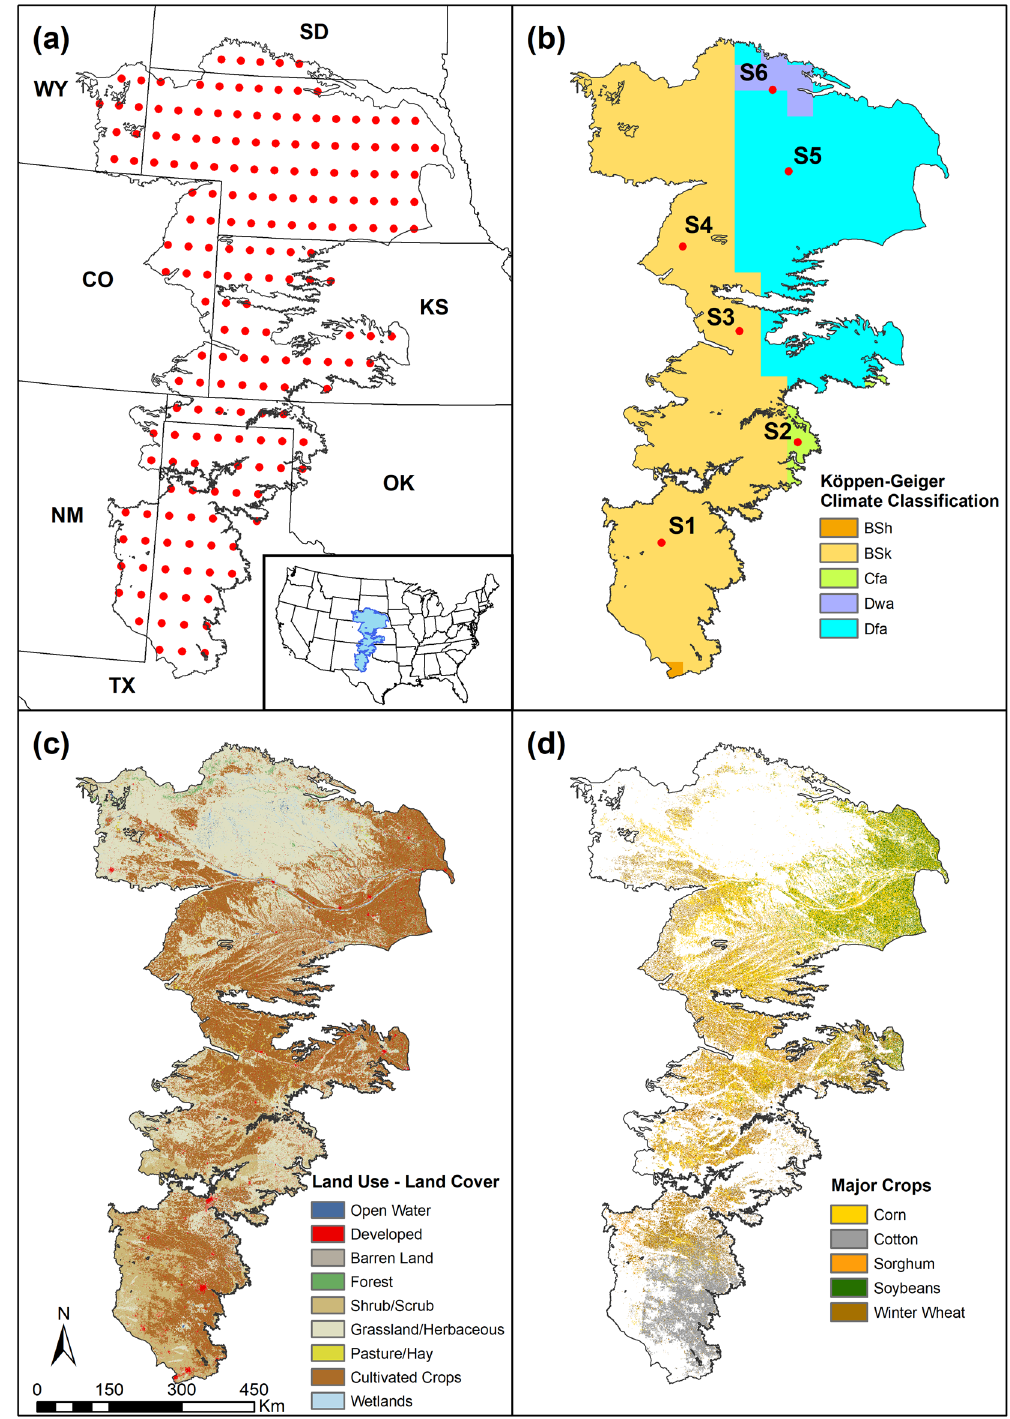
Figure 2. High Plains Aquifer (HPA)—( a ) Location and Grid Points used for Analysis; ( b ) Climate Zones within the Study Area and Representative Grid Locations; ( c ) General Land Use Land Cover (LULC) ( Source: NLCD, 2016 ); ( d ) Locations within the Aquifer where Major Crops are Produced (Source: USDA-NASS Cropscape,